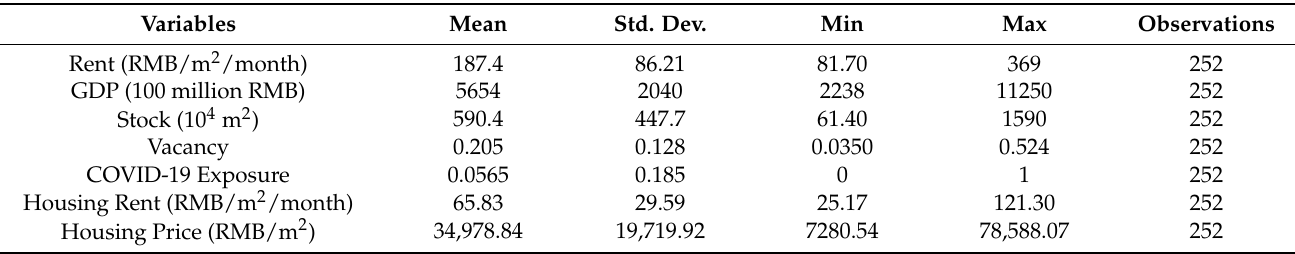
Table 2. Descriptive statistics of key variables.